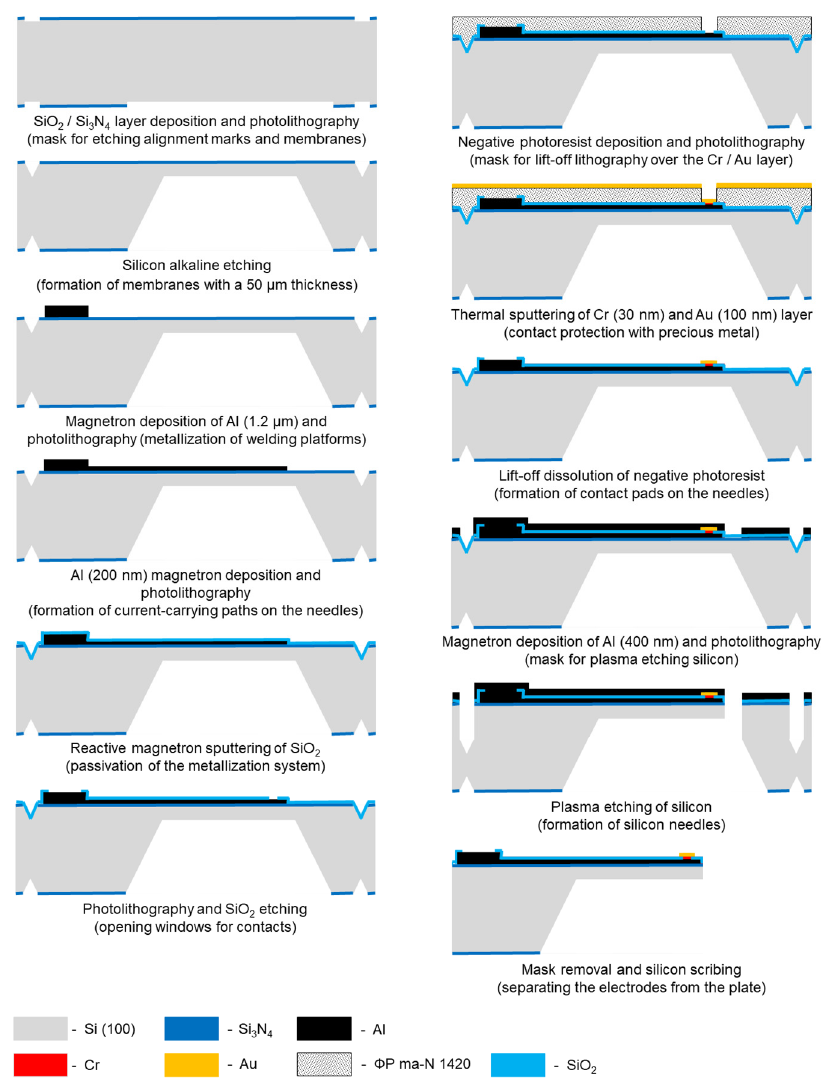
Figure 2. Technological route for the manufacture of multi-electrode array.